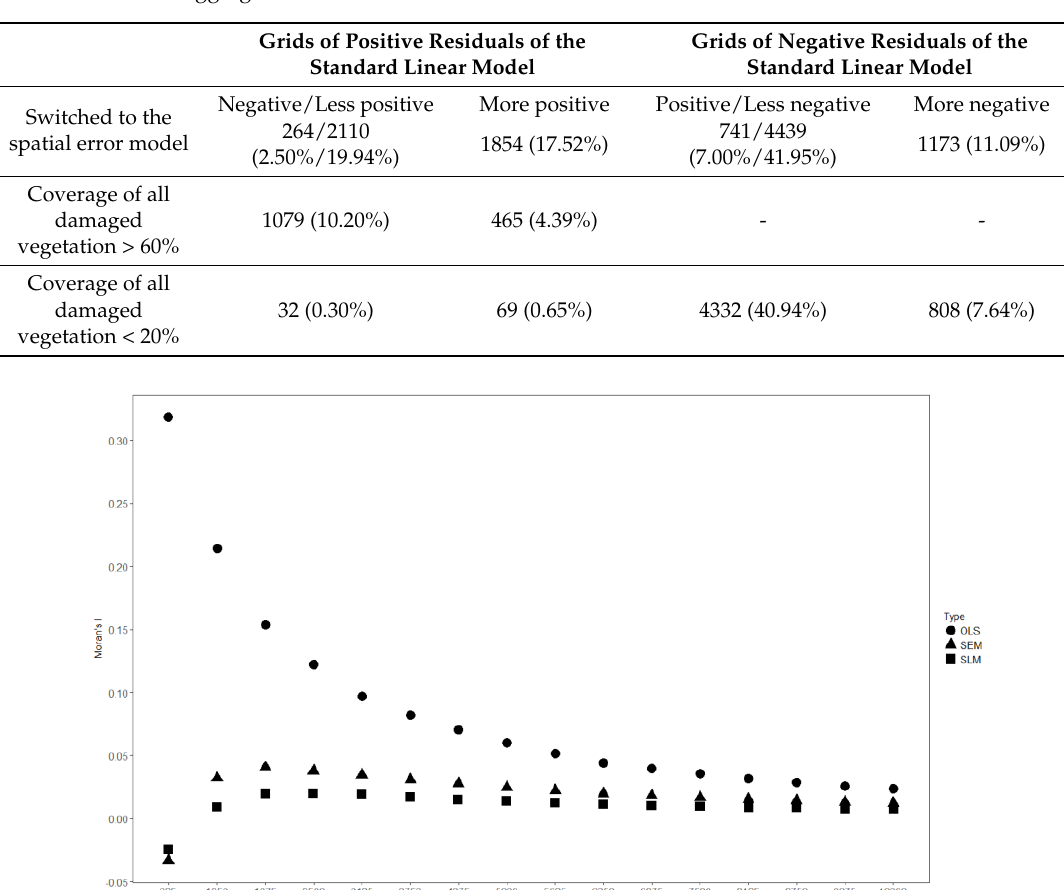
Figure 6. The correlograms of the Moran’s I of all damaged vegetation in the residuals of three models at the aggregation level 1 × 1. The points in black are significant ( P < 0.001). The points in red are insignificant ( P > 0.001). OLS: the standard linear model based on the ordinary least squares; SLM: spatial lag model; and SEM: spatial error model.